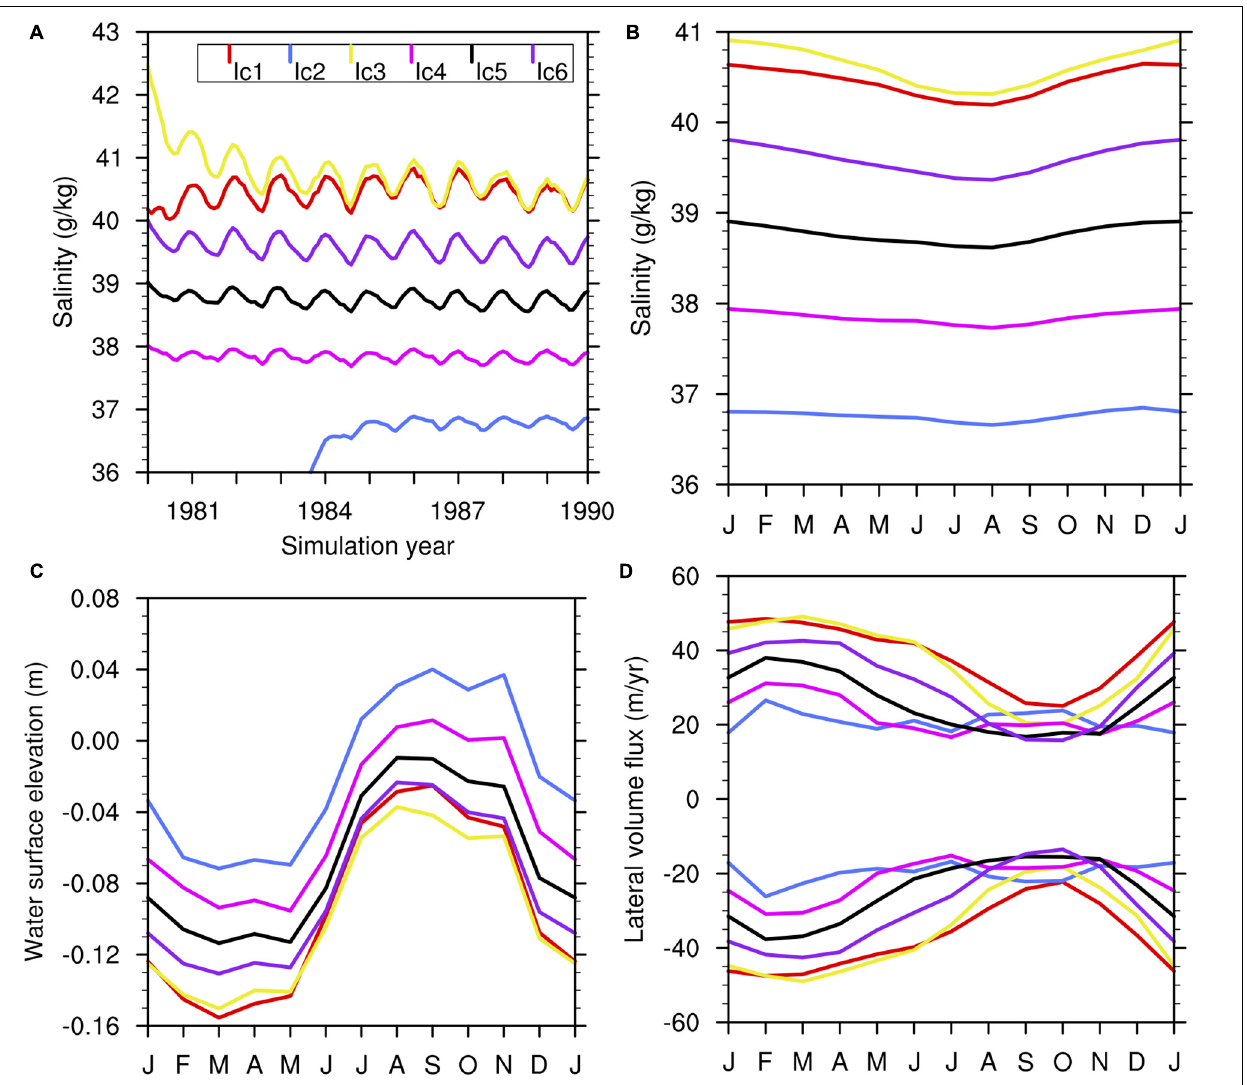
FIGURE 7 | Simulated Gulf dynamical properties of three equilibria (Ic4–Ic6) intermediate between Ic1 and Ic2 equilibria. (A) Monthly basin-average salinity [Ic2 salinity (as in Figure 3A ) is not plotted up to 36 g/kg improve clarity]. (B) Climatological monthly basin-average salinity. (C) Climatological monthly basin-average WSE (relative to the Indian Ocean). (D) climatological monthly lateral volume flux into the Gulf from the Indian Ocean (positive) and out of the Gulf to the Indian Ocean (negative) in the associated overturning